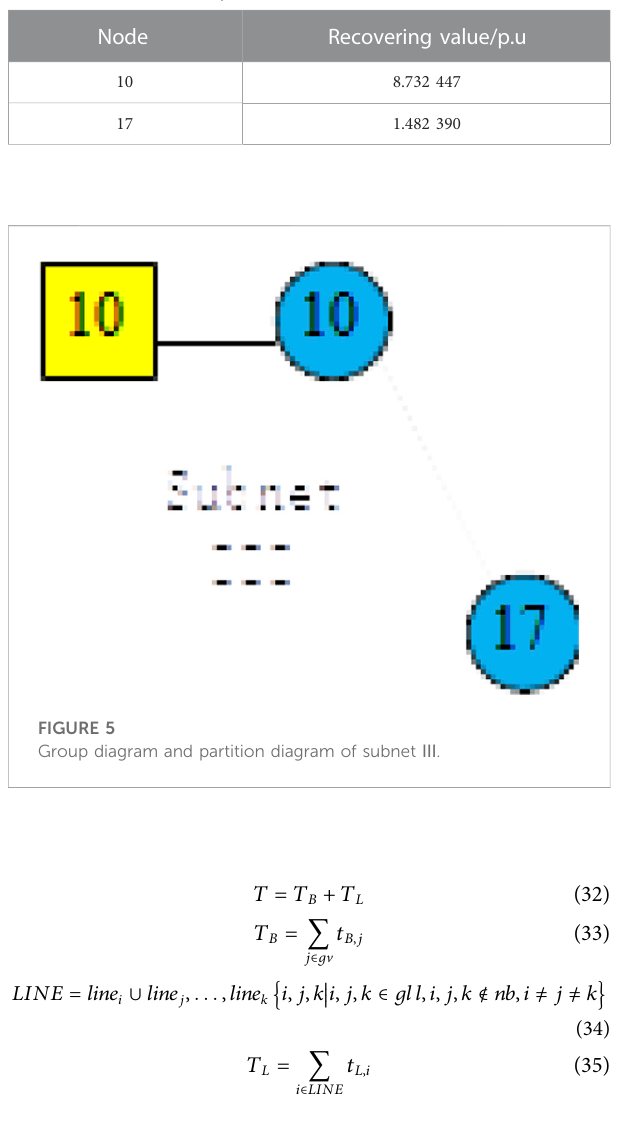
TABLE 9 Maximum recovery value of subnetwork.